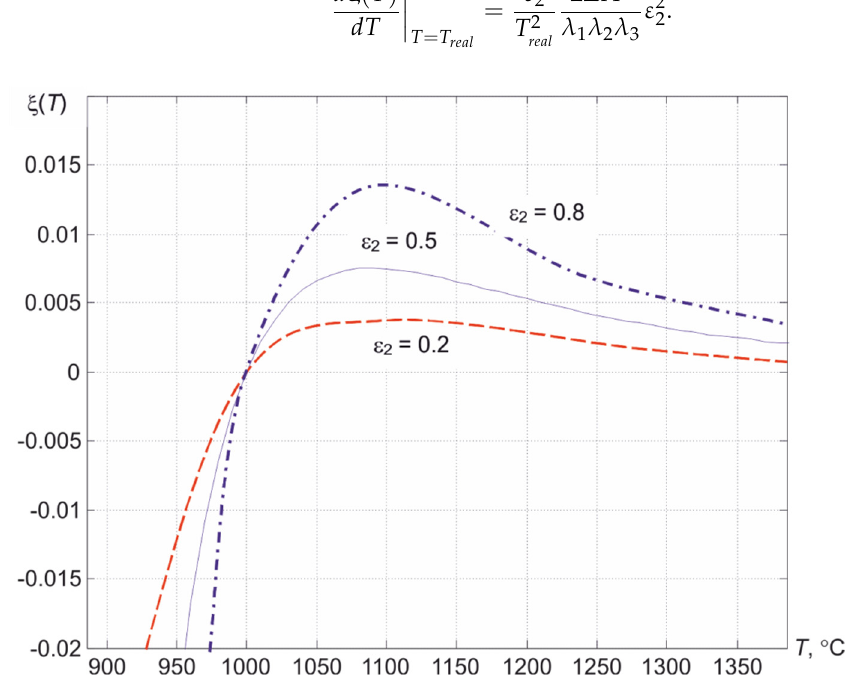
Figure 5. Dependence of the change in the value ξ on temperature at different ε 2 , λ 1 = 0.6, λ 2 = 0.75, λ 3 = 0.9 μ m and the value of the true temperature T real = 1000 ° С .